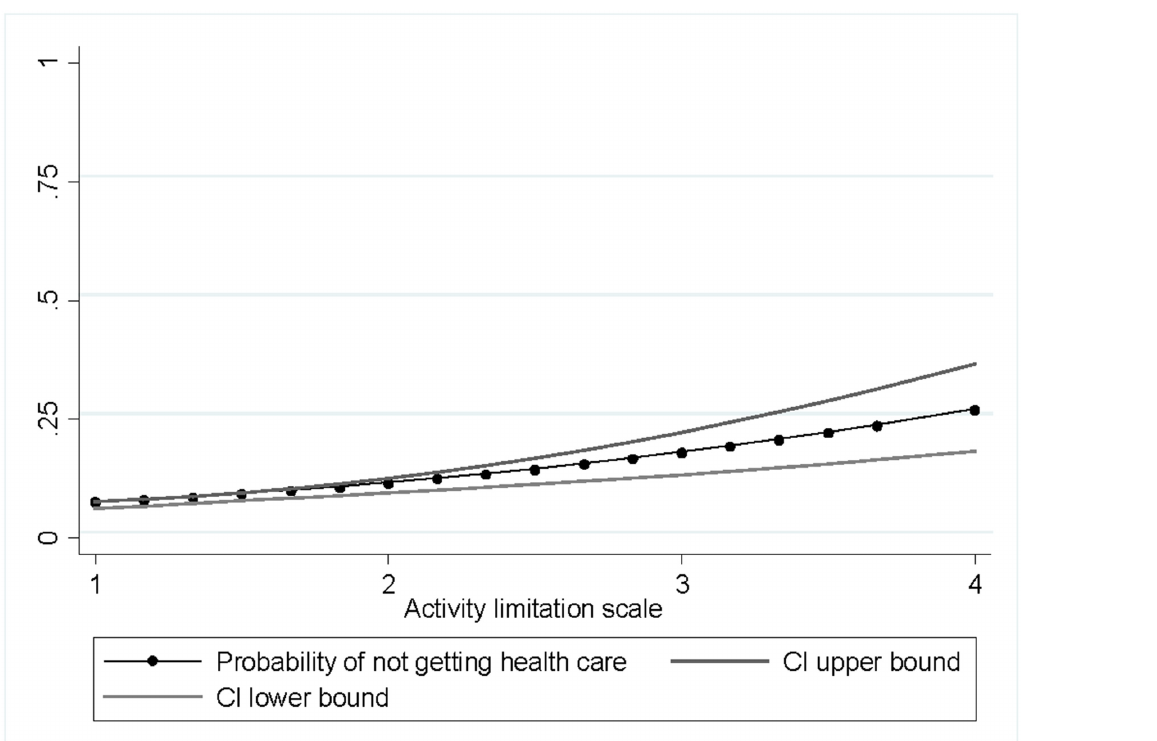
Fig 1. Probability of receiving health care last time needed, with 95 percent confidence